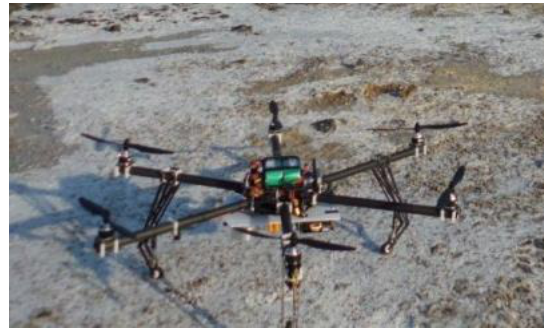
Figure 3. Hexacopter equipped with a thermal camera ready for the vertical take off.